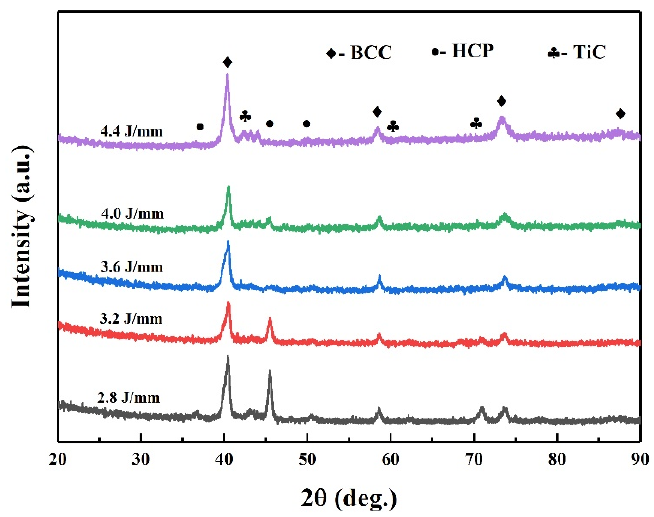
Figure 2. XRD patterns of LMD-fabricated specimens at various processing parameters.